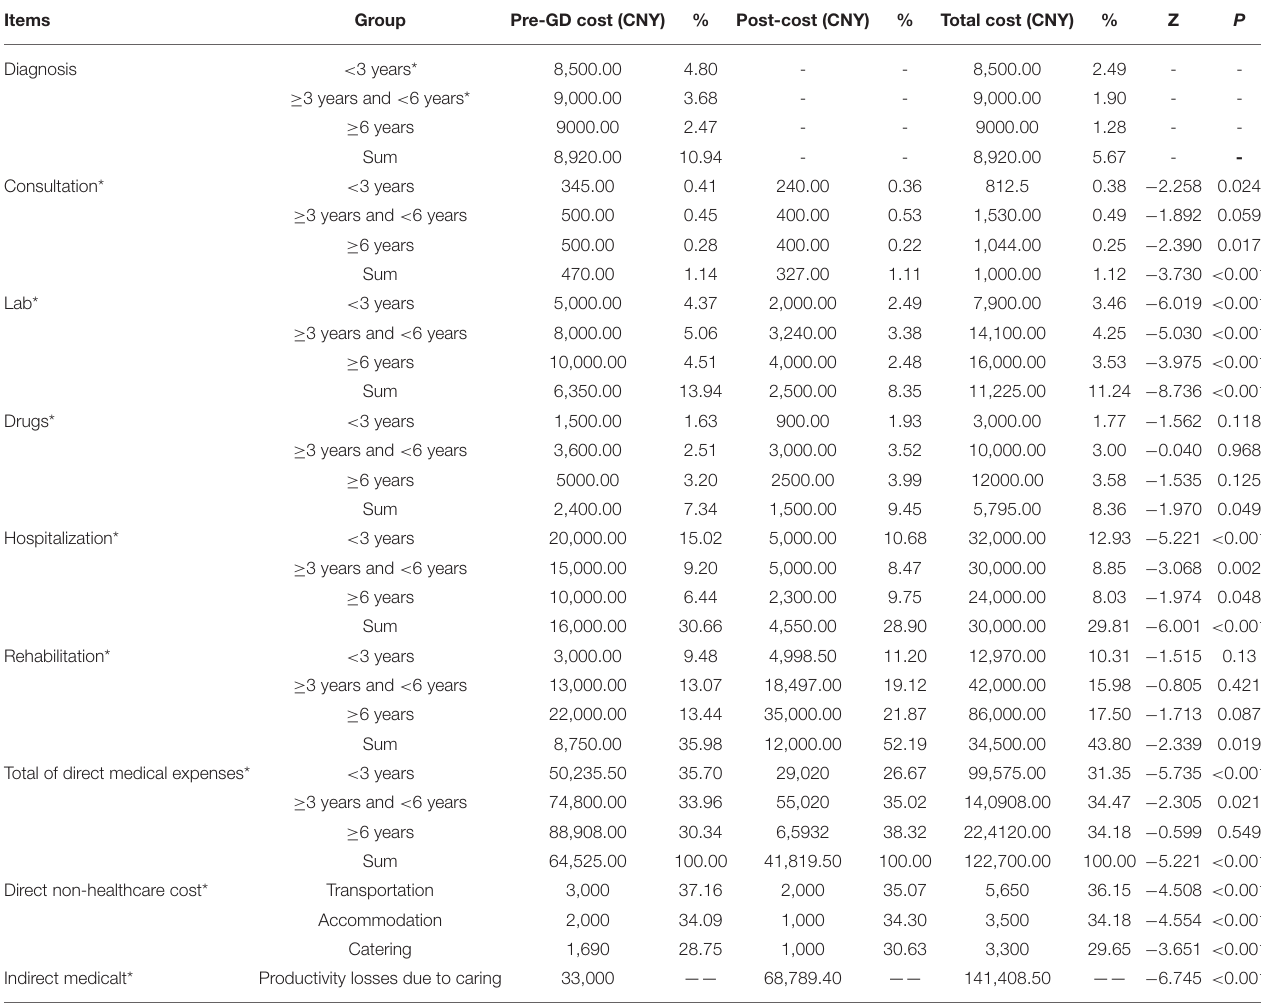
TABLE 2 | The total economic burden on average for NDDs in children (CNY, %) in different age